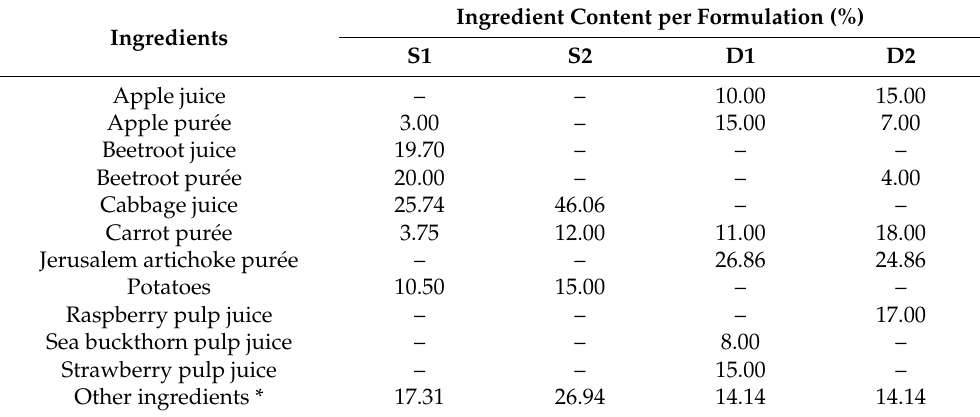
Table 2. Formulations of plant-based OD product prototypes.